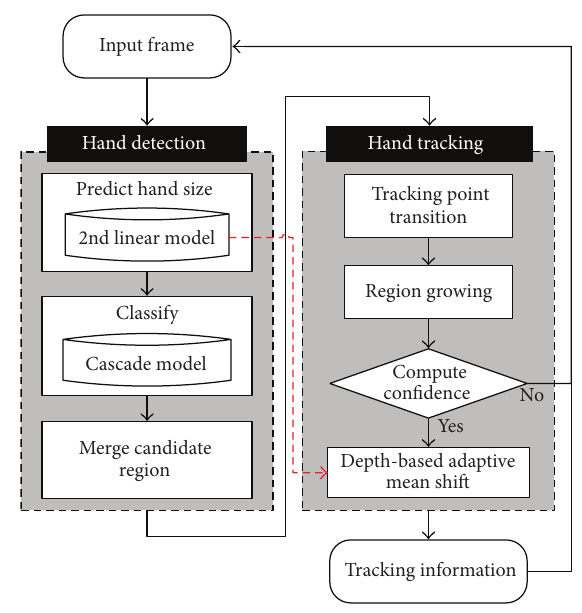
Figure 1: System